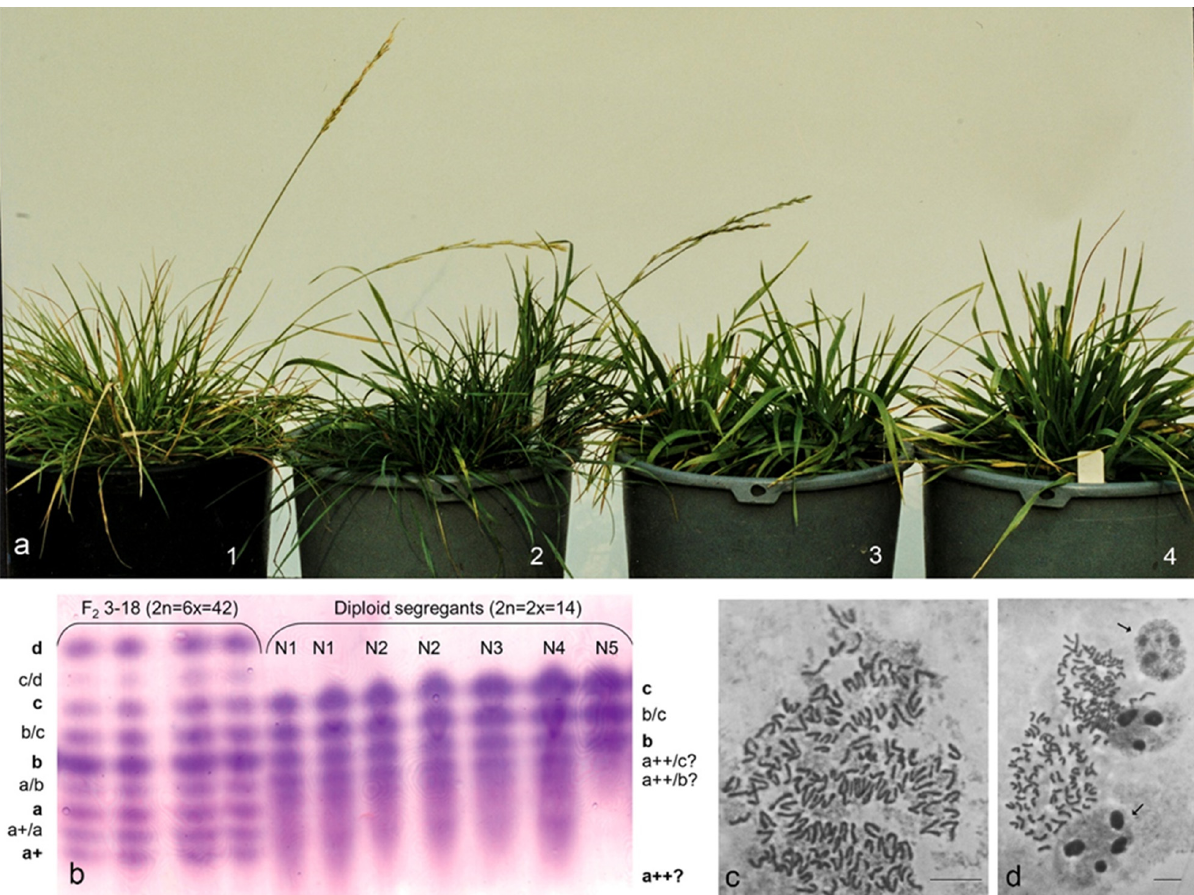
Figure 2. Phenotype view of F2 3-18 L. multiflorum × F. arundinacea donor and its split tiller deca- dents, PGI-2 isozyme pattern, and split anaphases in hyperploid cells. ( a ) 1—F2 3-18 donor plant (2n = 6x = 42); 2—identical clone (2n = 6x = 42), 3&4—diploid segregants (2n = 2x = 14). ( b ) PGI-2 isozyme separation, lanes 1–2 for the F2 3-18 donor plant, lanes 3–4 for the clones identical to donor, lanes 5–11 for diploid clonal plants, N1–5 labeled; F2 3-18 donor plant and its identical clones show a complex a+ , a , b , c , and d allelic profile (true isoform bands for the PGI-2 alleles are labeled in bold, hybrid bands in regular font), N1–4 diploids show a++bc , N5— b and c allele set. ( c ) Anaphases in hyperploid cell show several split division plates. ( d ) Metaphases with more than 42 chromosomes and nuclei of different sizes (arrowed) with variable nucleoli numbers and their sizes; chromosome counts are ca 163 in ( c ) and 68 in ( d ) (lower left). Scale bars = 10 and 20 µ m in ( c ) and ( d ),